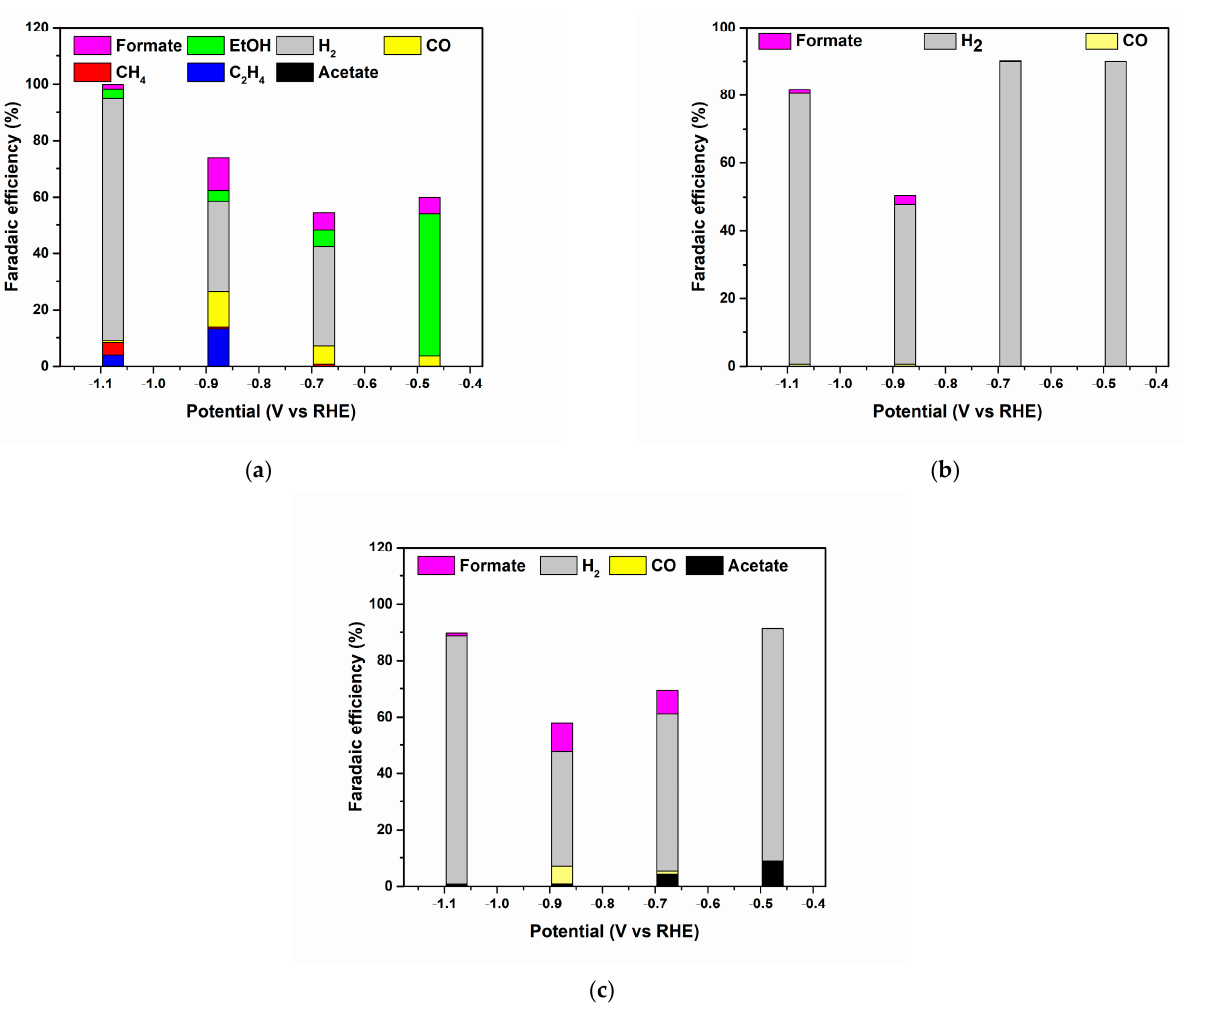
Figure 8. ( a – c ) Faradaic efficiencies of different products against the potential for Cu/Cu x O-PCC-0h, Cu/Cu x O-PCC-1h, and Cu/Cu x O-PCC-6h, respectively.